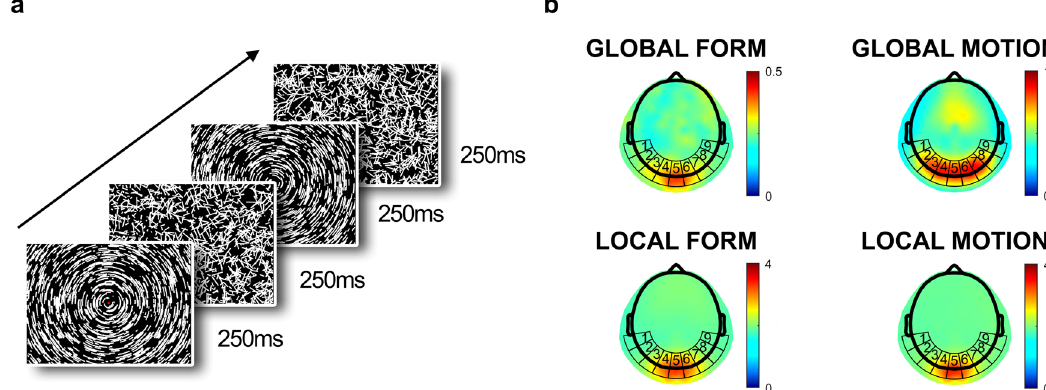
Fig. 1 Experimental stimuli and scalp topographies from typically developing infants. a Visual stimuli showed interchanging coherently and randomly oriented line segments (form conditions; shown here) or coherently and randomly moving dots (motion conditions; see Supplementary Video 1) to evoke global and local processing, respectively. b Overhead mean topographical maps for the four conditions based on the Normative Sample of 5-month-old infants. Distinctive visual cortex activation topographies were observed in both Global Motion and Global Form conditions (statistics in main text); however, visibly widespread activity across bilateral lateral electrodes were observed only in the former. Local Form and Motion produced largely similar activation concentrated on the medial